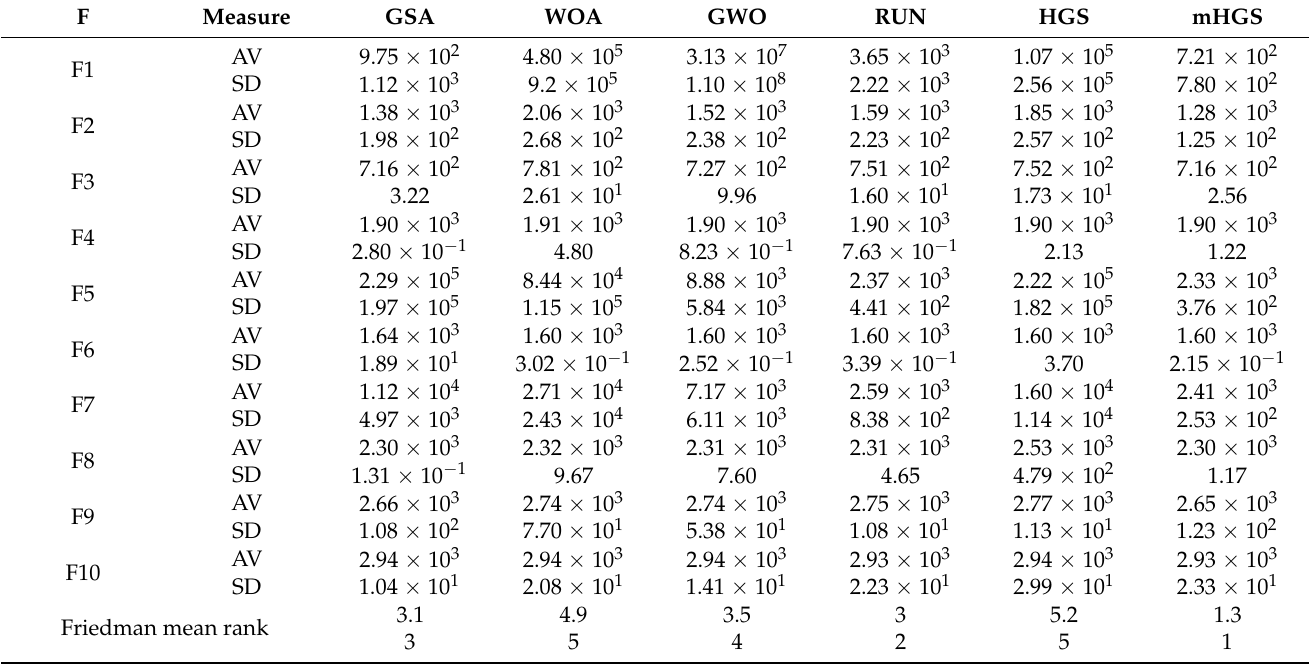
Table 3. The AV and SD of the 30-experimental-run study of the considered optimizers applied to the CEC’2020 cost functions when the dimension is